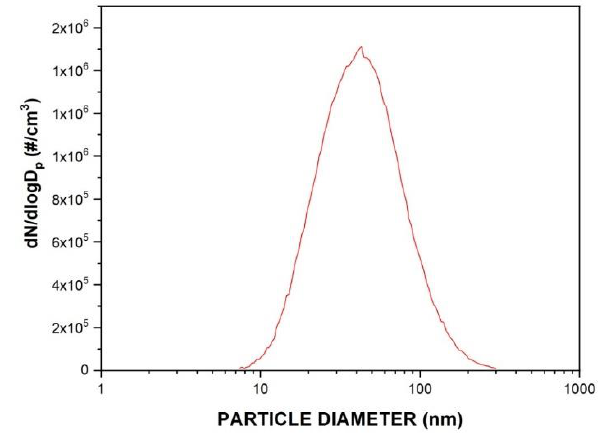
Figure 3. Nanoparticle distribution using NaCl solution.